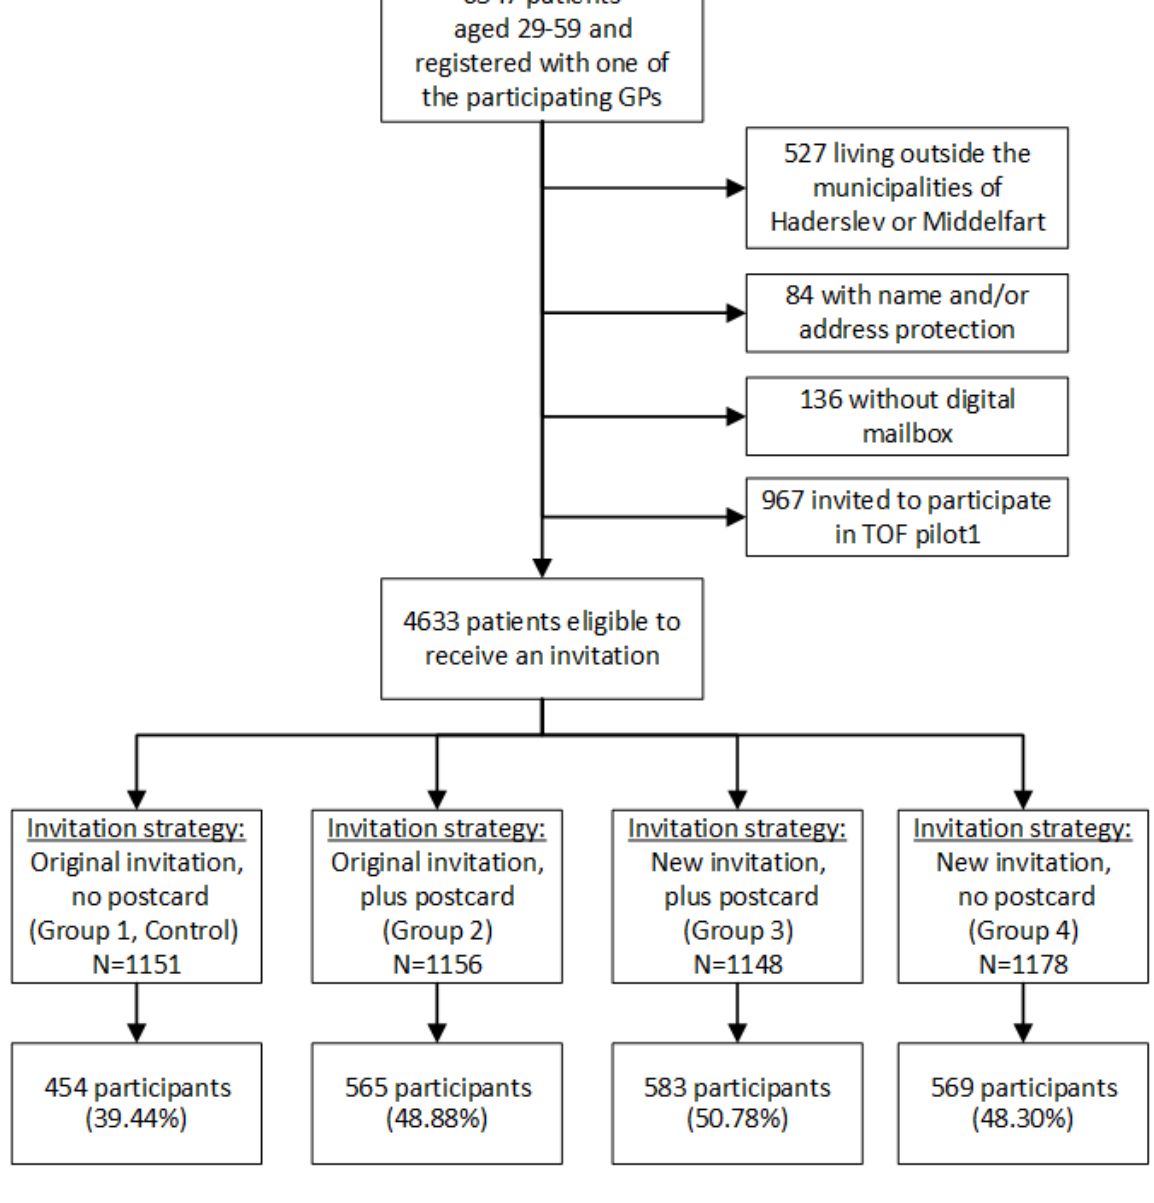
Figure 1. Flow diagram of a preventive primary care program (TOF pilot2) from initial sampling of patients to participation rates in each of four invitation groups. GP: general